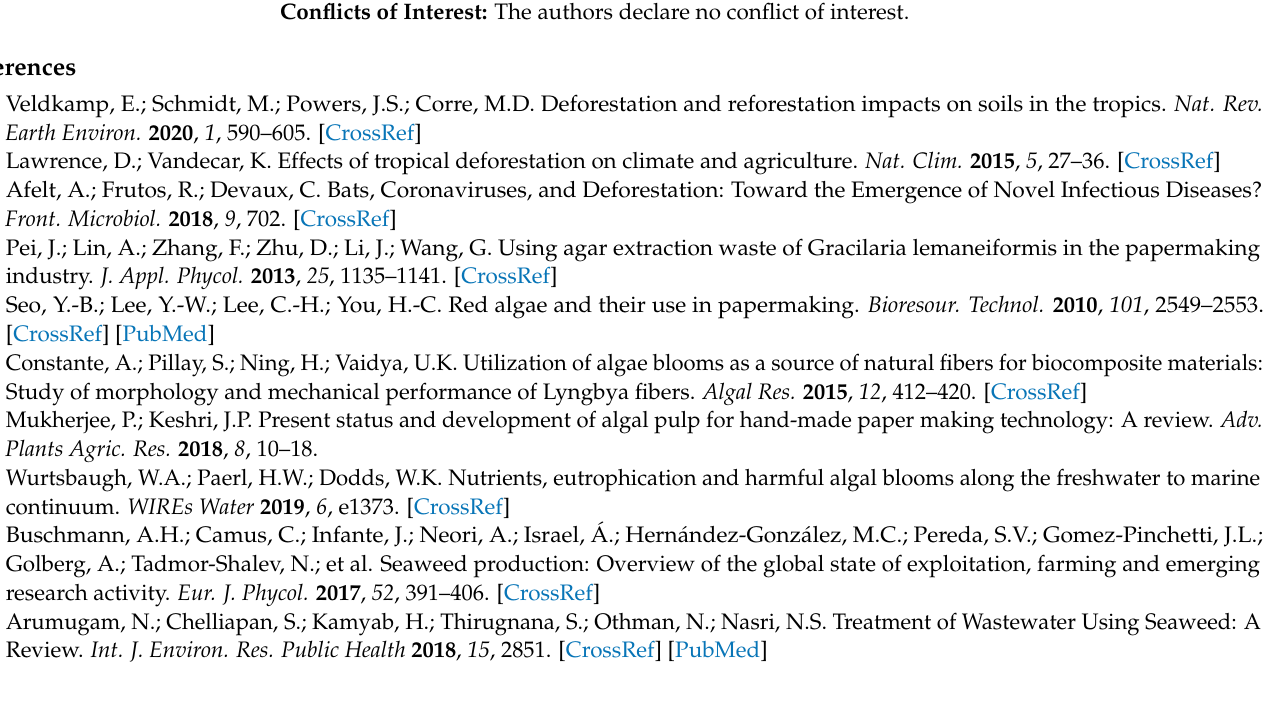
paper, Figure S2: A photograph and schematic illustration of spray nozzle used for spray coating, Figure S3: FT-IR spectra of uncoated and chitosan-coated seaweed paper and pure chitosan, Figure S4: Photographs of Low S% seaweed paper samples coated with chitosan after immersing them in hot water, Figure S5: Stress-strain curves of (a–c) Low S% and (d-f) High S% seaweed papers coated with chitosan with varying MW’s and concentrations, Figure S6: Stress-strain curves of non-wood plant papers coated with chitosan with varying MW’s and